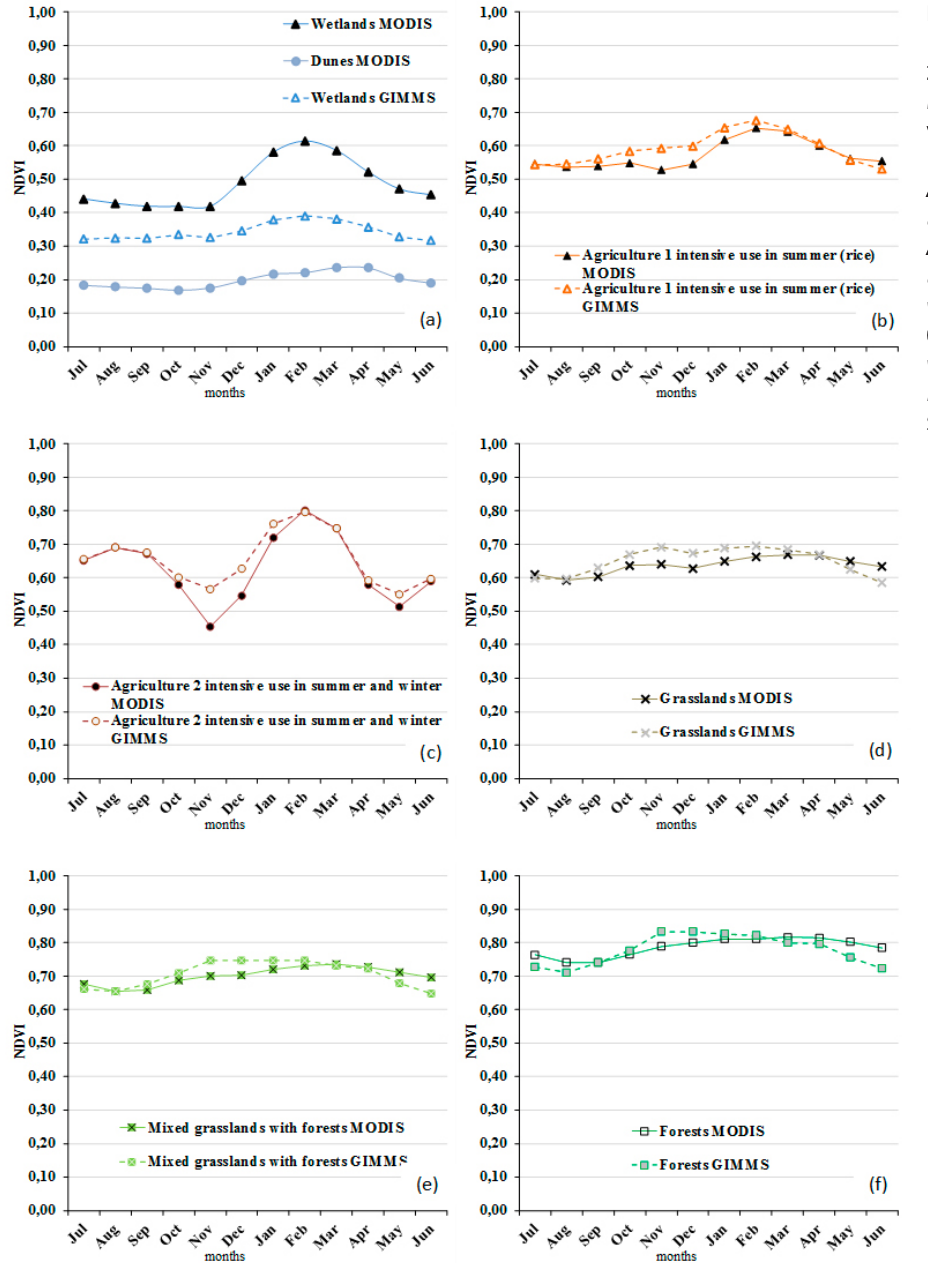
Figure 3. Mean annual profiles from 2000 to 2008 of GIMMS and MODIS NDVI of